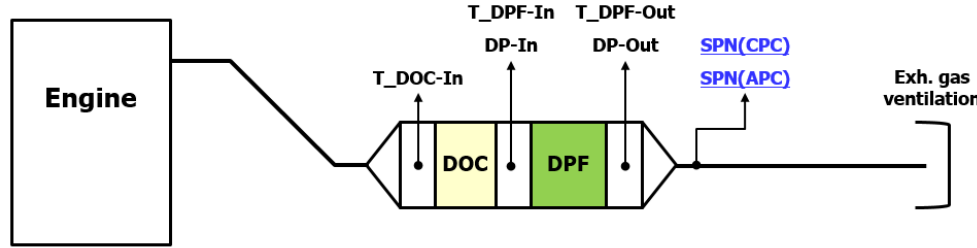
Figure 6. Exhaust gas aftertreatment system layout consisting a DOC and a DPF. DOC = Diesel Oxidation Catalyst; DPF = Diesel Particle Filter; SPN = Solid Particle Number; APC = AVL Particle Counter; CPC = Condensation Particle Counter.